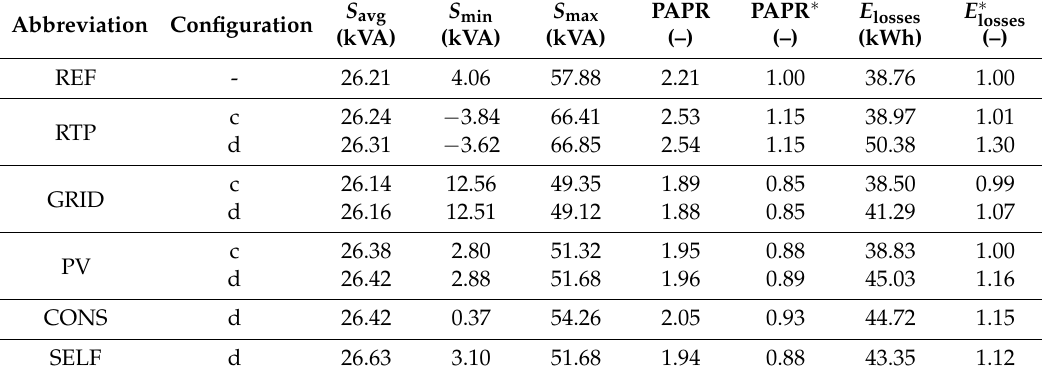
Table A1. PAPR, power, and loss results achieved for a single, central storage (c) and multiple, distributed storages (d) driven by different incentives. The superscript * refers to normed quantities = E losses with respect to the reference case, i.e., E ∗ and analogously for PAPR. E losses,REF losses